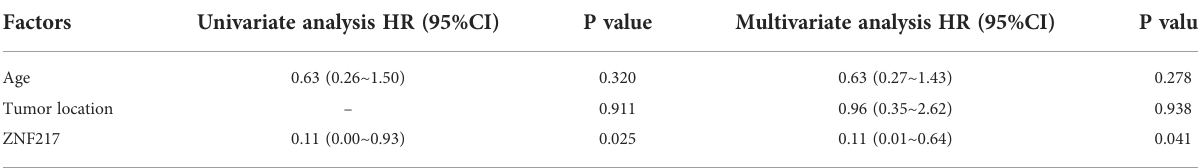
TABLE 4 Univariant and multivariant analysis of patients strati fi ed by early-stage (stage0-II) and late-stage (stage III-IV).